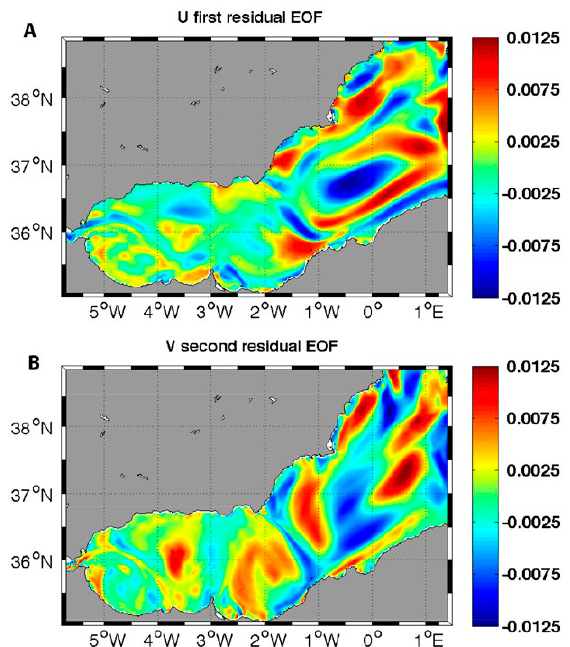
Fig. 7. – A, first residual EOF of U; B, and second residual EOF of